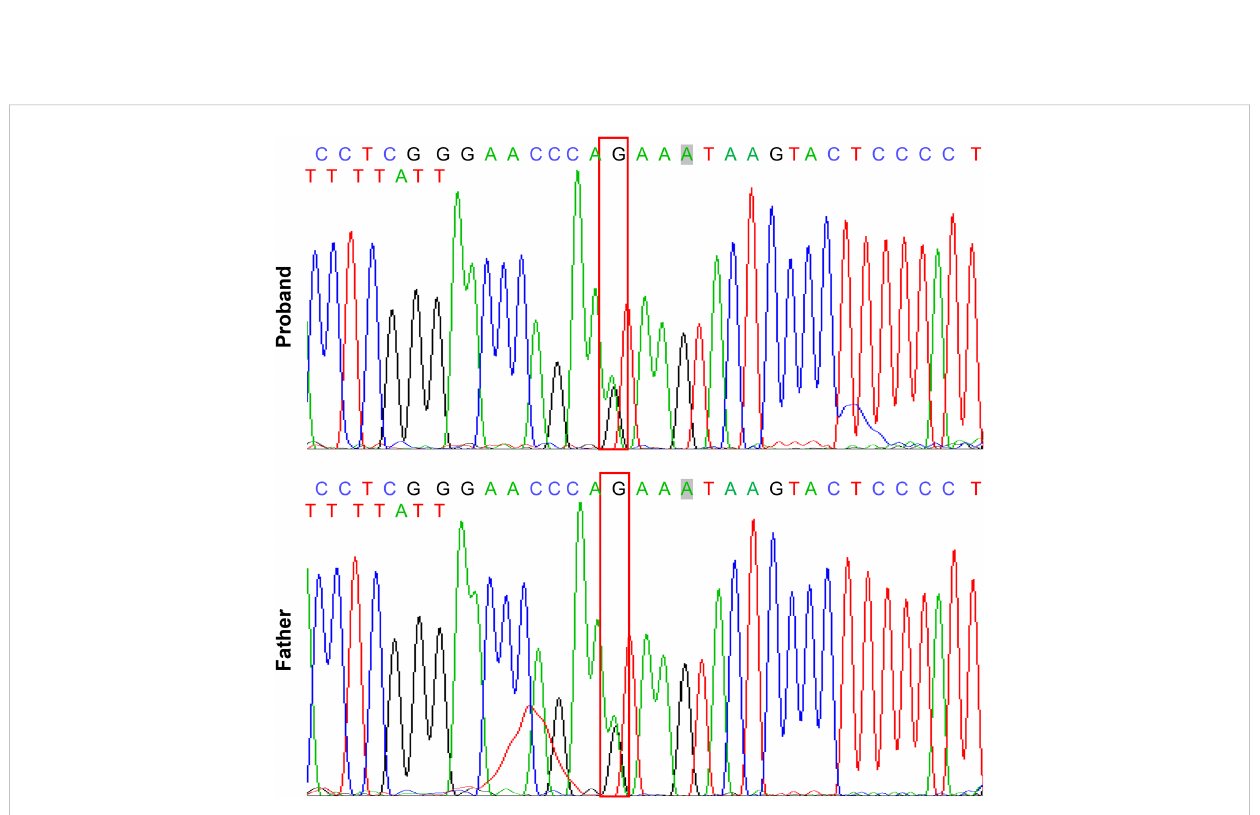
FIGURE 3 Mutation analysis of RUNX2 gene in the patients with CCD. Sequencing results showing the heterozygous mutant of RUNX2 (c. 685 + 1G>A, p. Arg228Asp). The box indicates the mutation